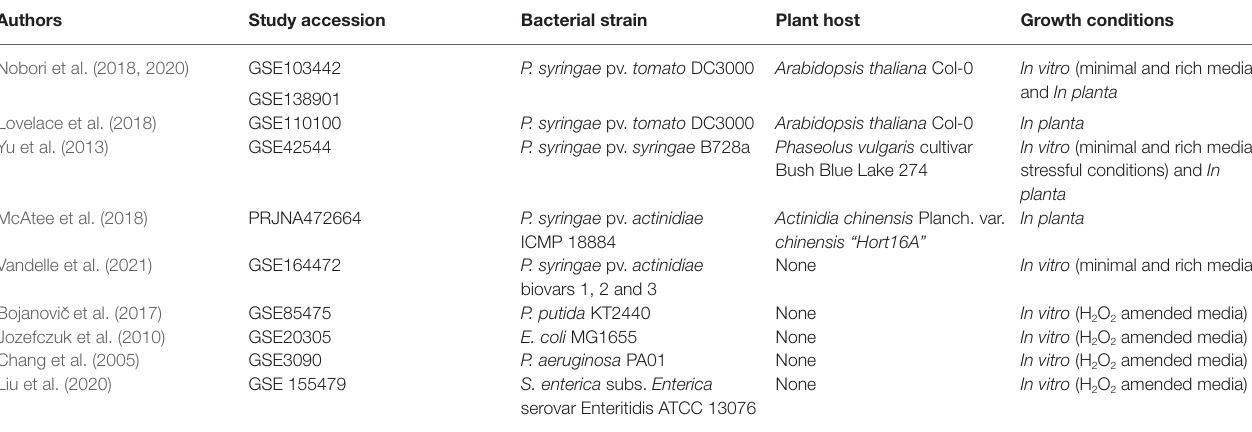
TABLE 1 | Description of the data sets used for the meta-analysis in this